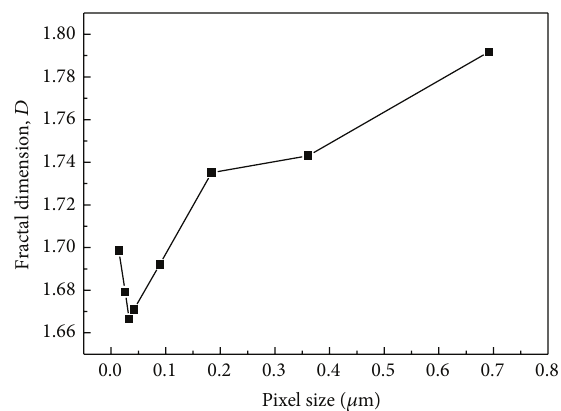
Figure 4: Fractal dimension versus image resolution for porous metal fiber materials. Table 3: Fractal dimensions of pore structure for different regions chosen. Porosity/% 73.1% 88.2% Region chosen